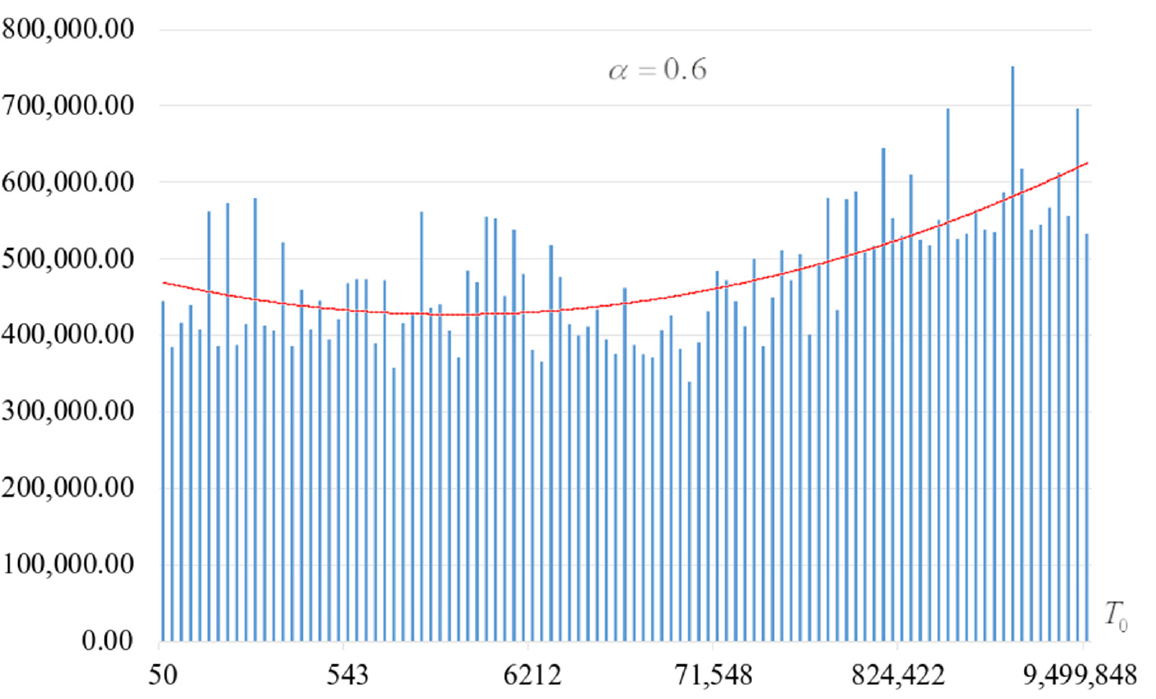
Figure 18. The summary number of the arithmetic mean number of iterations when searching for the target S-box, α = 0.6.